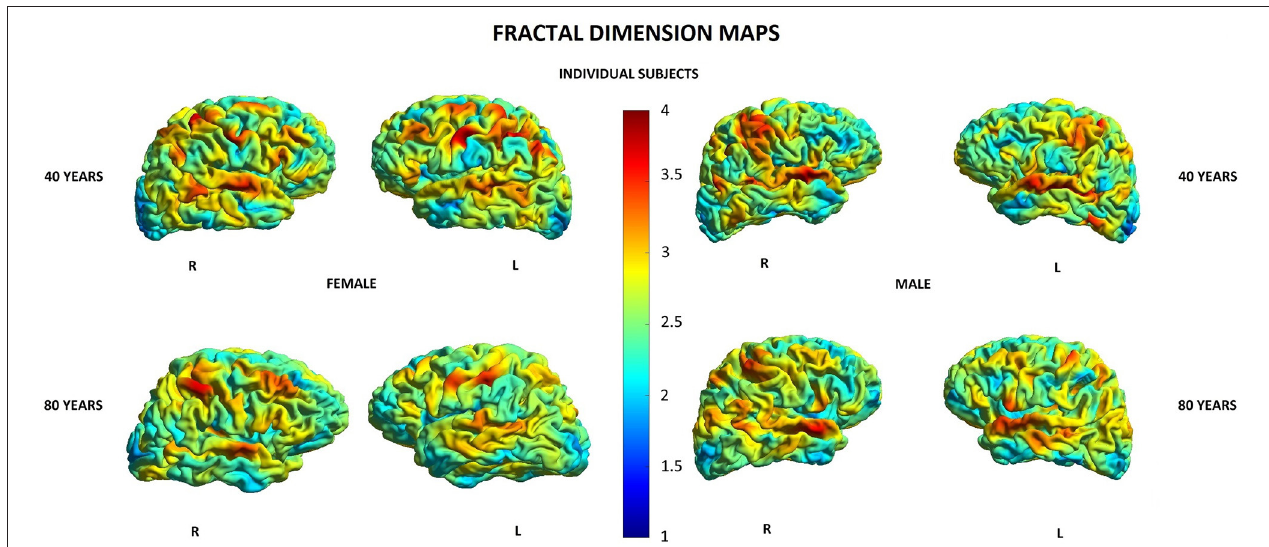
FIGURE 6 | Cortical maps of age-related distribution of fractional dimension in 40- and 80-year-old female and male individual subjects. Lateral views of right (R) and left (L)